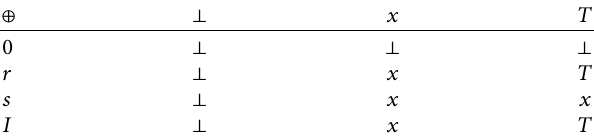
Figure 2: Illustration of M. Table 2: Binary opreation subject to ⊕ .